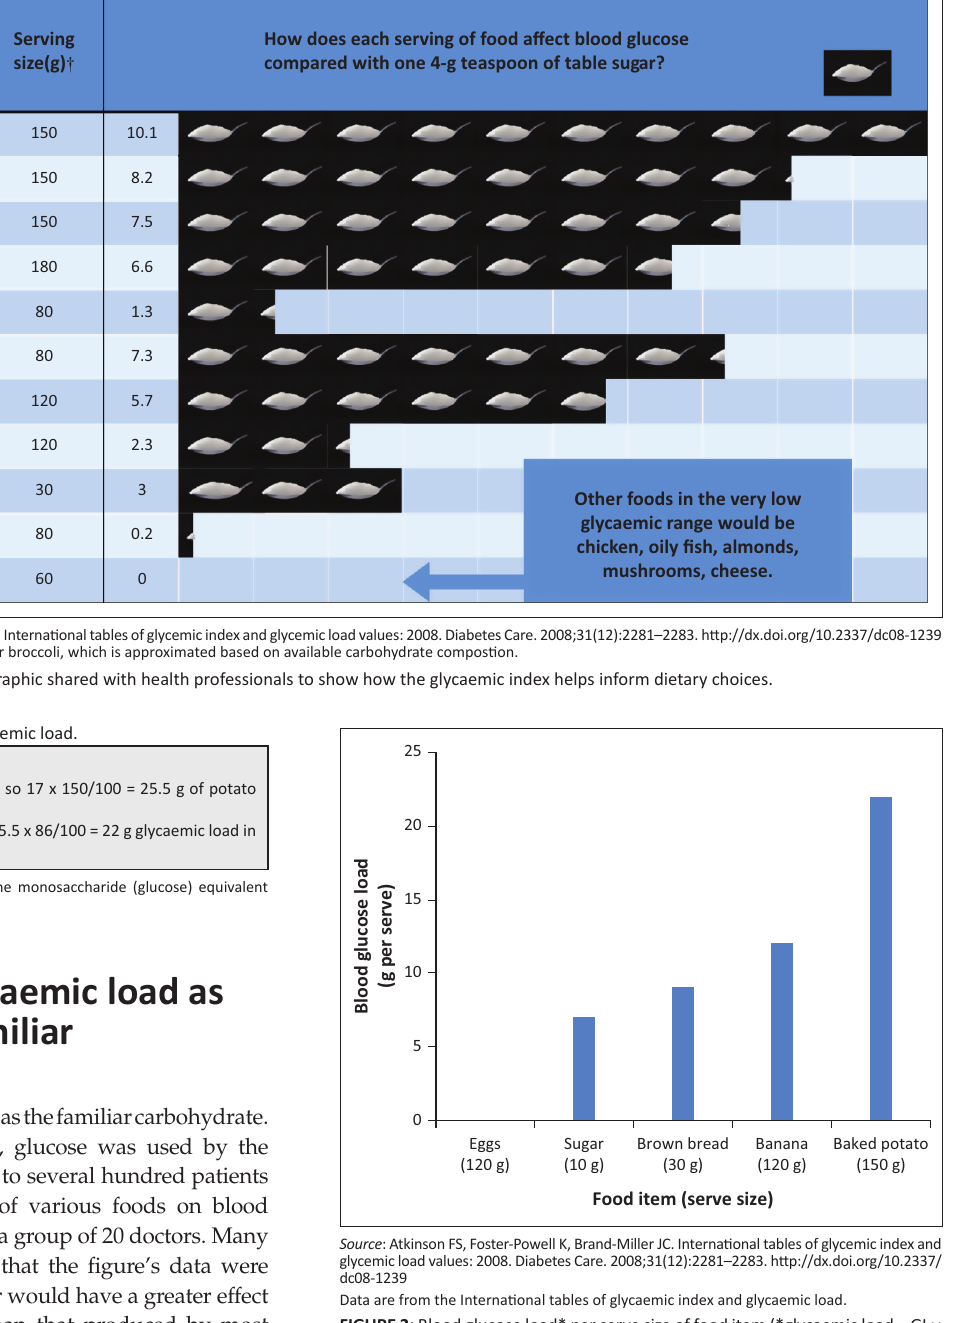
FIGURE 2: Blood glucose load* per serve size of food item (*glycaemic load = GI × carbohydrate amount g per serve/100). Sugar is table sugar consumed in water as a